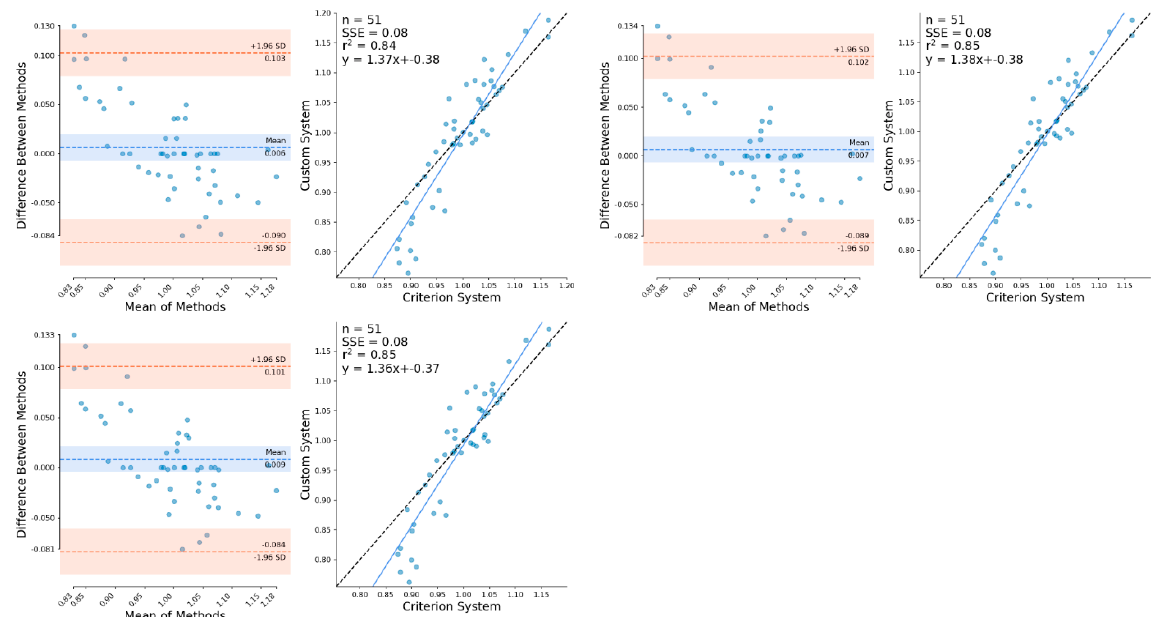
Figure A6. Bland-Altman and linear regression plots demonstrating the differences between OpenPose unfiltered (top-left), low-pass filtered (top-right) and Kalman smoothed (lower-left) CoM vertical position against marker-based CoM vertical position during sprinting.